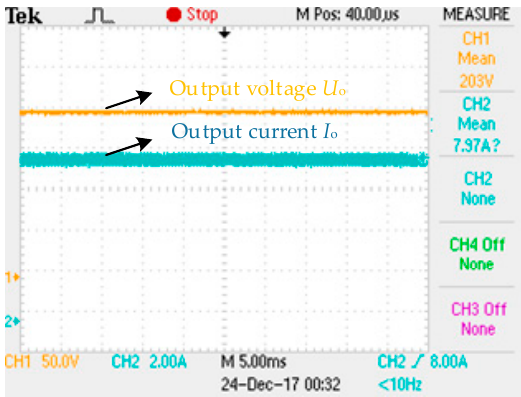
Figure 16. The output voltage and current waveforms in the secondary side at constant current stage.